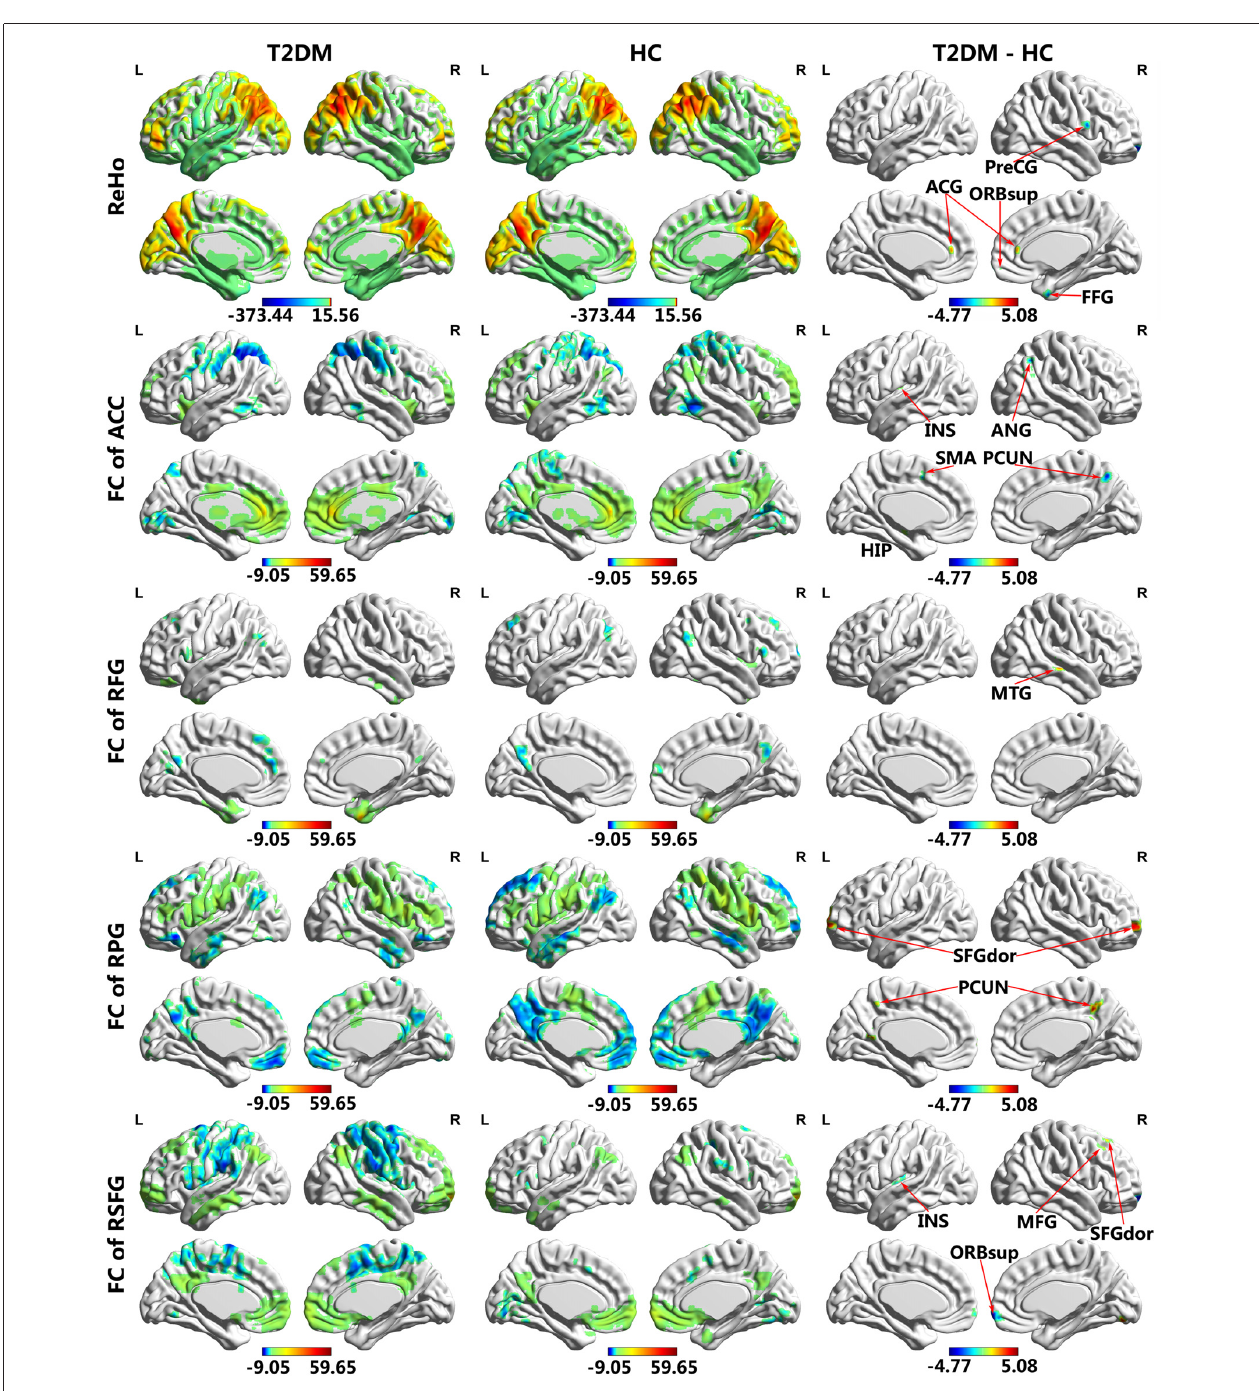
FIGURE 1 | Regional homogeneity (ReHo) and functional connectivity (FC) maps of intra-group and inter-group comparisons. Voxel p < 0.005 (AlphaSim correction, cluster p < 0.01, cluster size > 16 voxels). Color scale denotes the t value. ACG, anterior cingulate gyrus; FFG, fusiform gyrus; PreCG, precentral gyrus; ORBsupmed, superior frontal gyrus, medial orbital; INS, insula; ANG, angular gyrus; HIP, hippocampus; SMA, supplementary motor area; PCUN, precuneus; MTG, middle temporal gyrus; SFGdor, superior frontal gyrus, dorsolateral; ORBsup, superior frontal gyrus, orbital part; MFG, middle frontal gyrus; R, Right; L, Left.